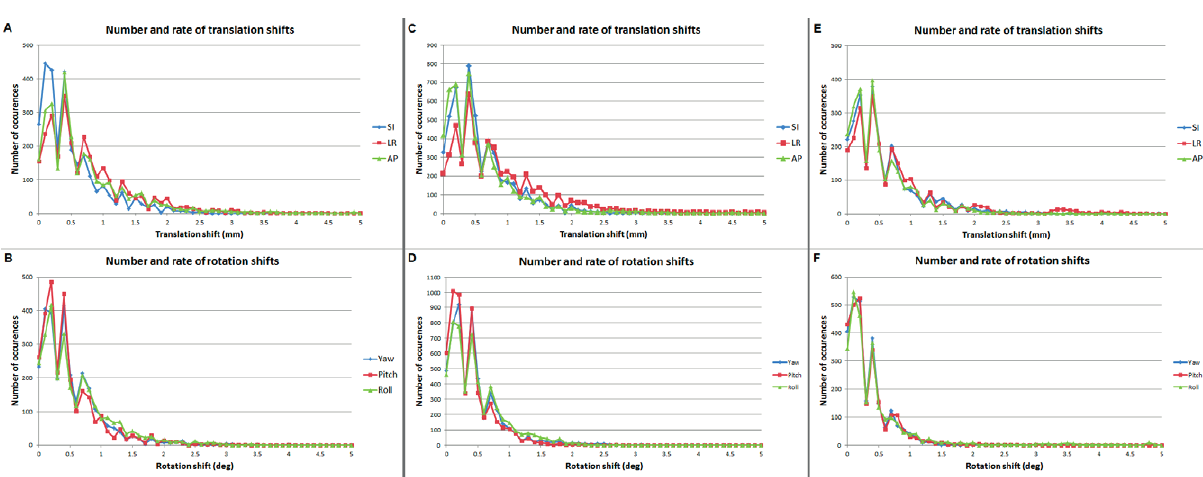
Fig. 1. The number and rate of spine shifts for the cervical (A, B), thoracic (C, D) and lumbar-sacral regions of the spine (E, F).